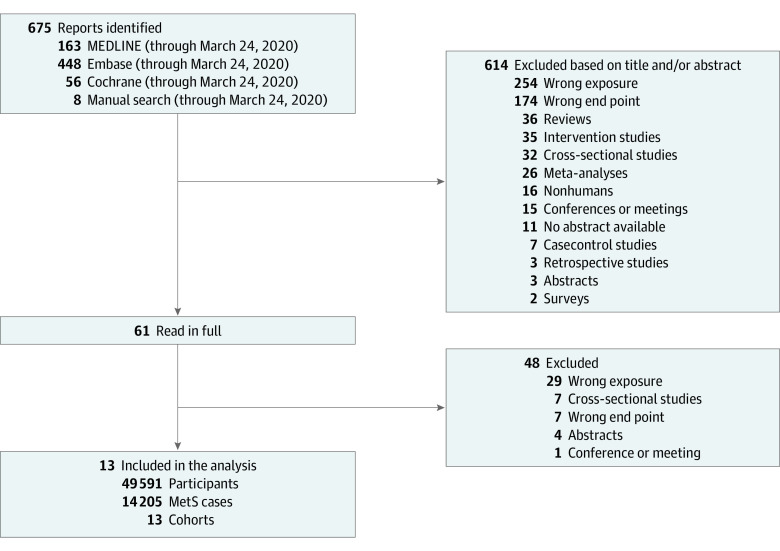
Diagram of Study SelectionMetS indicates metabolic syndrome.